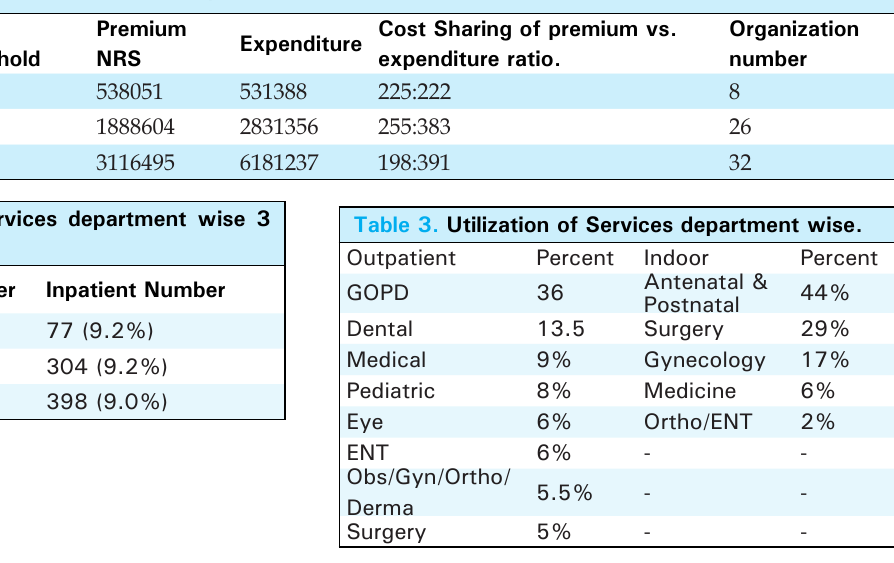
Table 1. Number of households, members and premium.